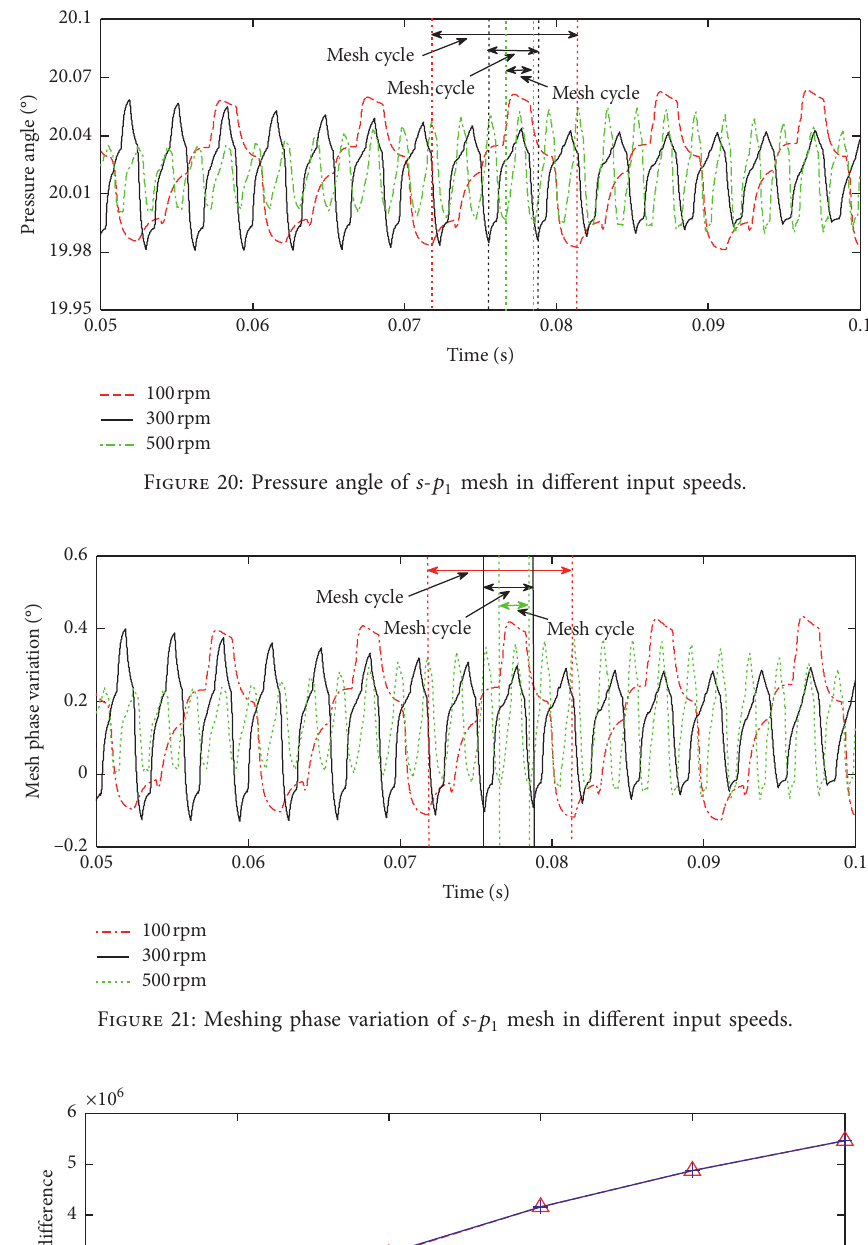
mesh in different input speeds. 1